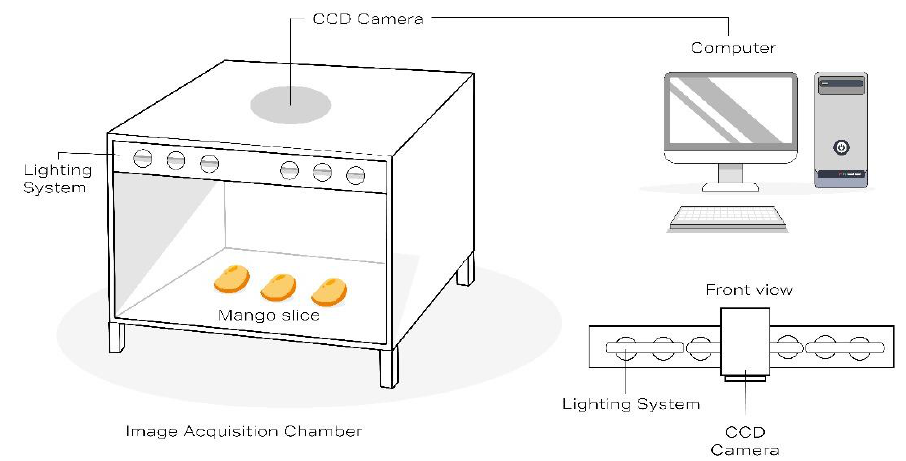
Figure 2. Schematic illustration of the computer vision system setup including the image acquisition chamber for the color measurement of mango slices. CCD: Charge-coupled device camera The camera was mounted 120 cm above the test samples and inserted into the di ff usion disk.